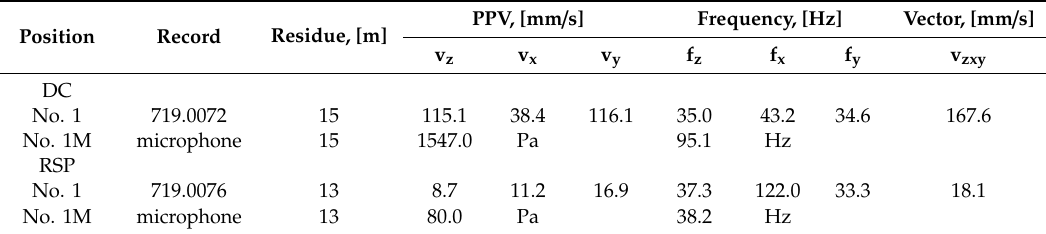
Table 3. Results of calculations of thermodynamic parameters of the tested gas-generating